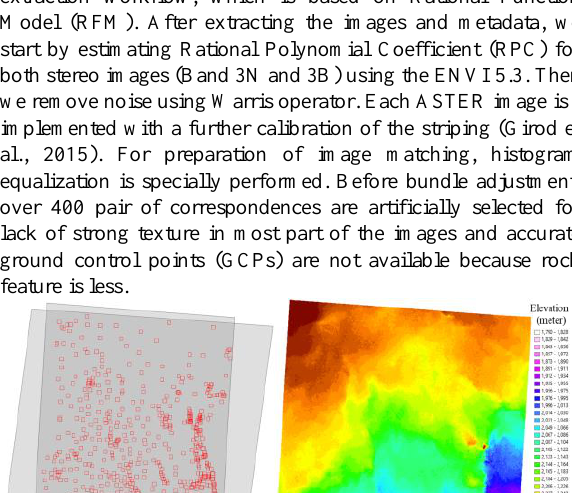
Figure 1. Study area and ASTER image coverage. (a) Two red boxes are ASTER L1A nadir and backward image boundary.